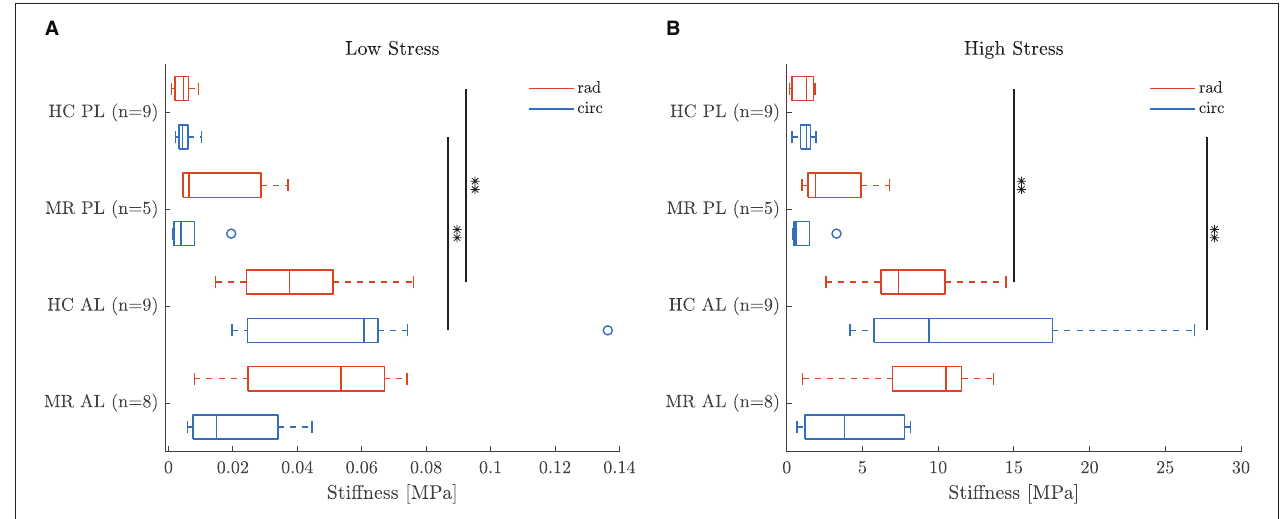
FIGURE 8 | Boxplot of the leaflet sample stiffness at (A) low and (B) high stress per group. **Indicates a highly statistically significant difference ( p < 0.01).